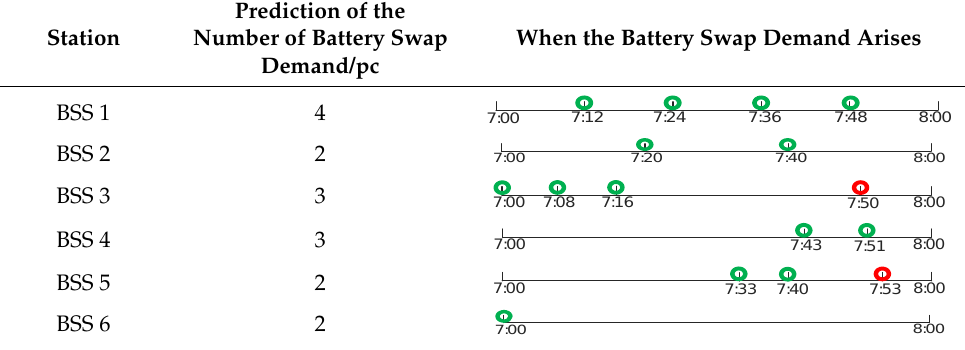
Figure 7. Comparison of FR power of BSS 3 under the strategy of this paper and the strategy of capacity allocation distri- bution based on capacity.